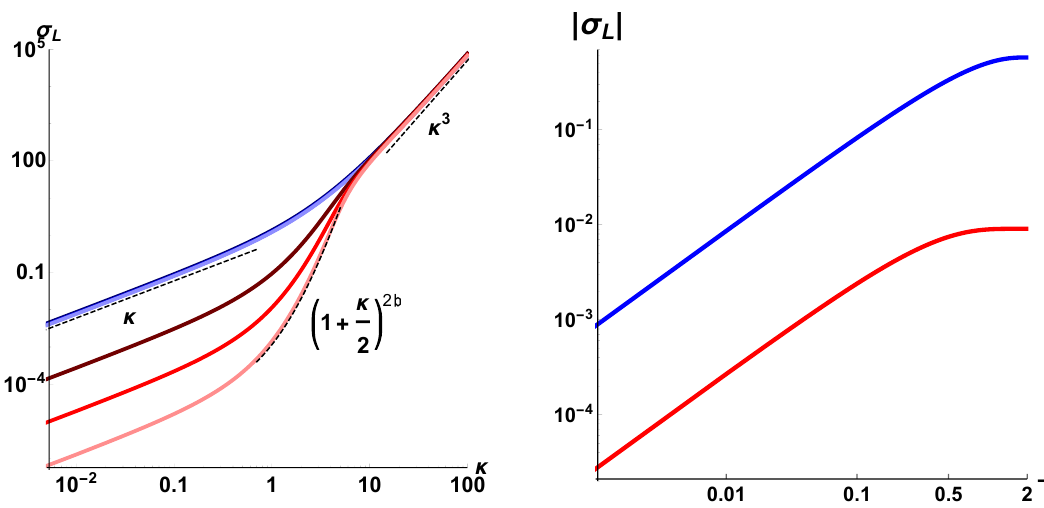
Figure 5 . Left: non linear bulk elastic response for various potentials W ( X; Z ) at small tempera- ture T=m = 0 : 01 (blue lines) and T=m = 1 (red lines). At large deformations all the lines asymptote the universal scaling (3.34) (cid:24) (cid:20) 3 . At large temperatures there is a transition between linear and (cid:0) (cid:1) 2 b cubic scaling that grows as (cid:11) 2 b = 1 + (cid:20) . Right: absolute value of (cid:27) L ( (cid:20) ) for a = b = 3 and 2 T=m = 0 ; 1 (blue, red) as a function of (cid:0) (cid:20)